Question: What does this figure show? Answer in one sentence.
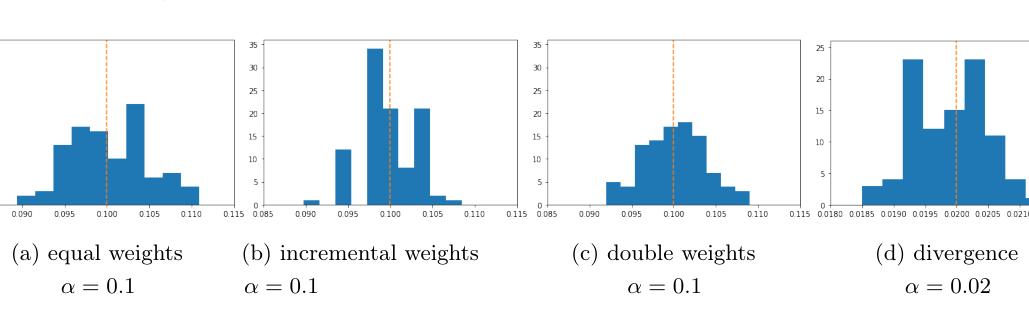
Answer: Risk distributions of different scenarios at a fixed α on the simulated dataset.